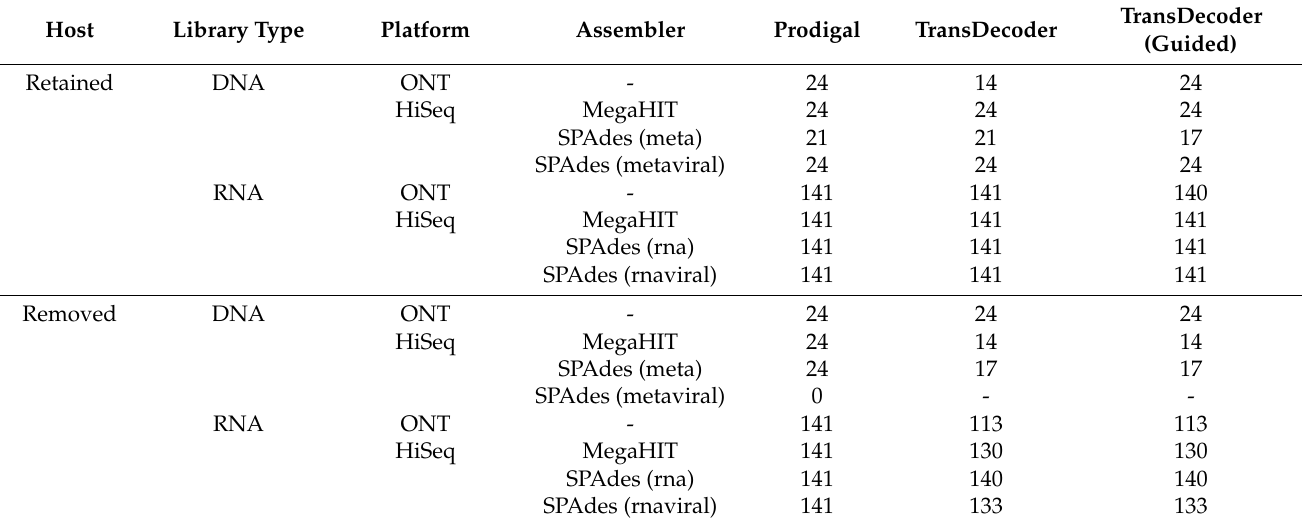
Table 6. The number of successfully completed assemblies for each assembler and subsequent coding region predictions with each approach. The number of samples processed were 24 for DNA and 141 for RNA